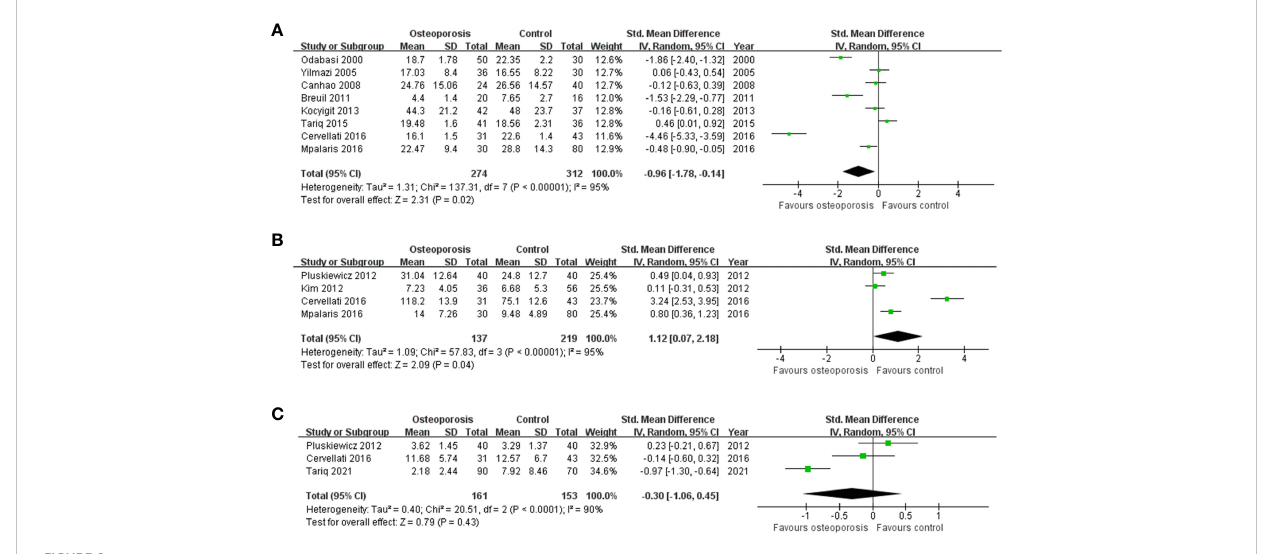
FIGURE 2 Forest plot depicting the differences in adipokine levels according to osteoporosis status in postmenopausal women (A) Leptin, (B) adiponectin, and (C)